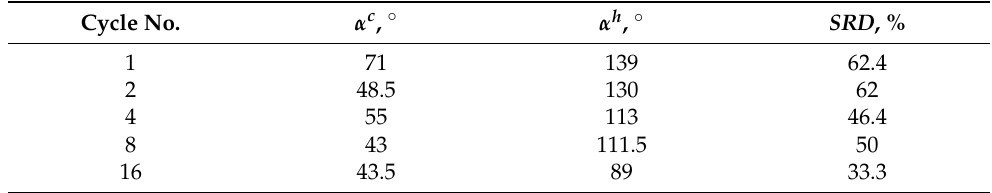
Table 1. Average deflection angles of the cold ( α c ) and hot ( α h ) shapes from Figure 2a together with the shape recovery degree ( SRD ). Cycle No.